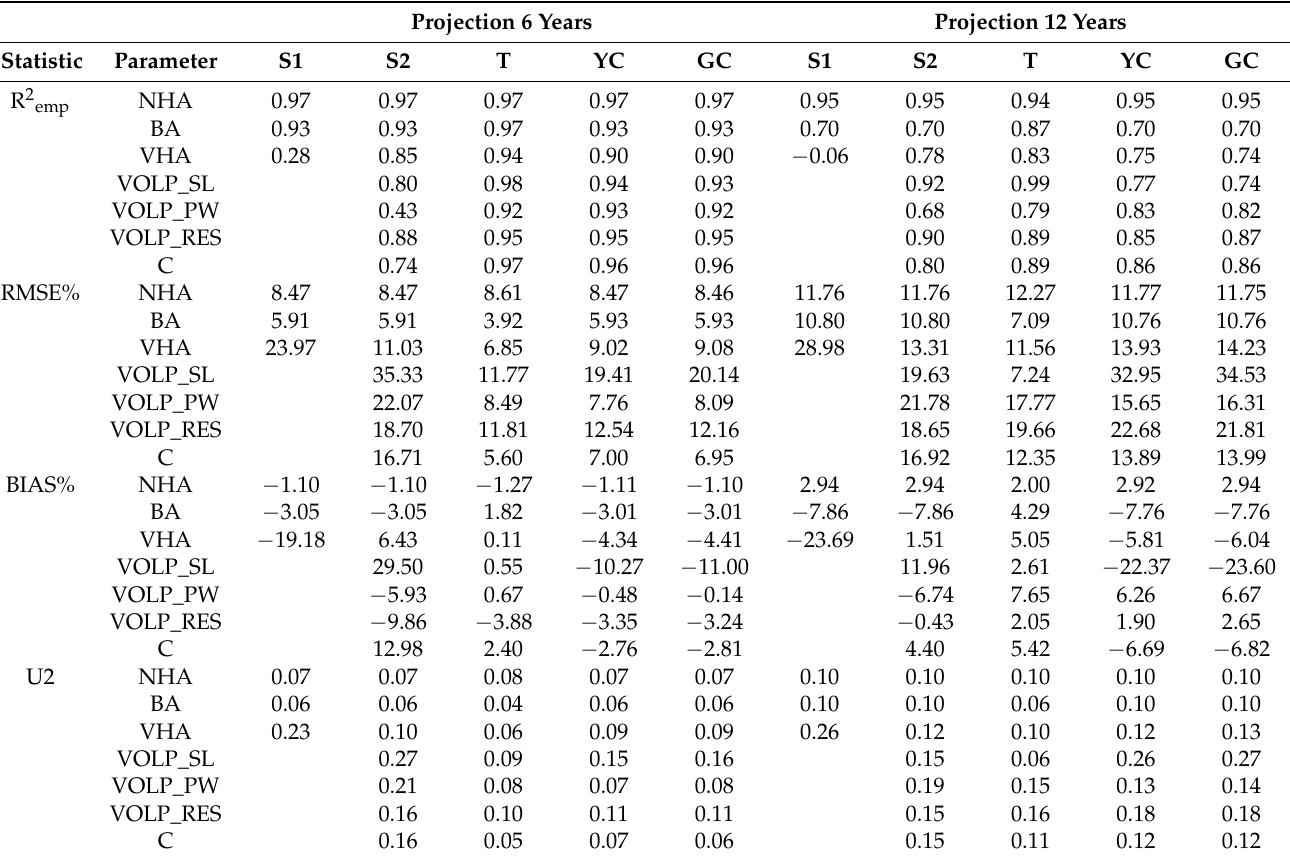
Table 2. Goodness-of-fit statistics for each simulation (S1, S2, T, YC, and GC, see text for definitions) for number